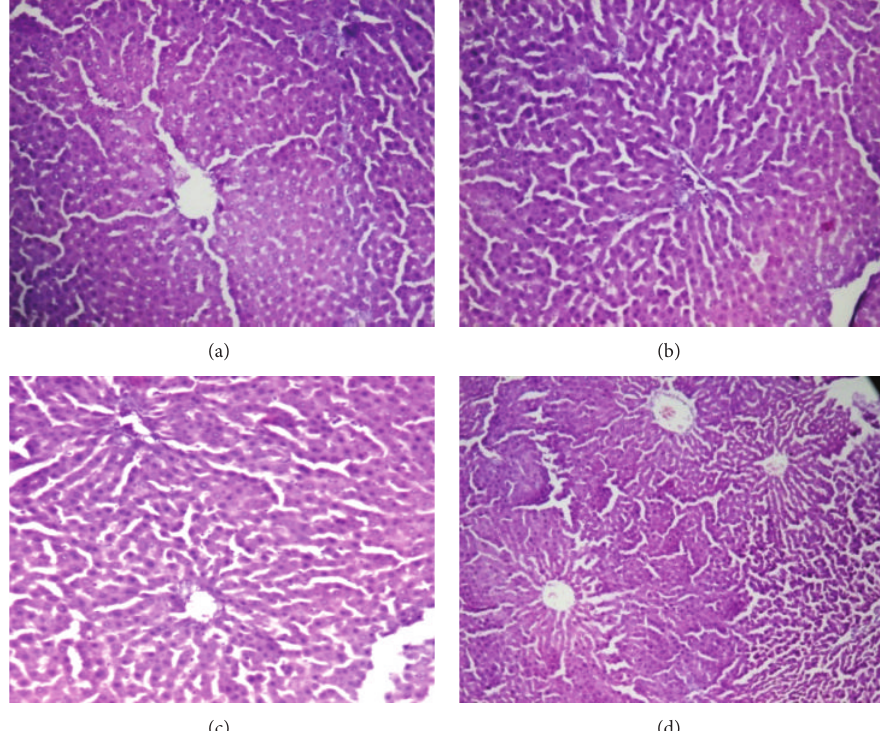
Figure 1: Histology of liver (H&E, 100x) of control and OSE-treated animals. (a) Section of liver from control animals revealed normal architecture and hepatic cells with granulated cytoplasm; ((b), (c), and (d)) liver from OSE (200, 400, and 800 mg/kg)-treated animals exhibited normal architecture of hepatocytes and hepatic cells with granulated